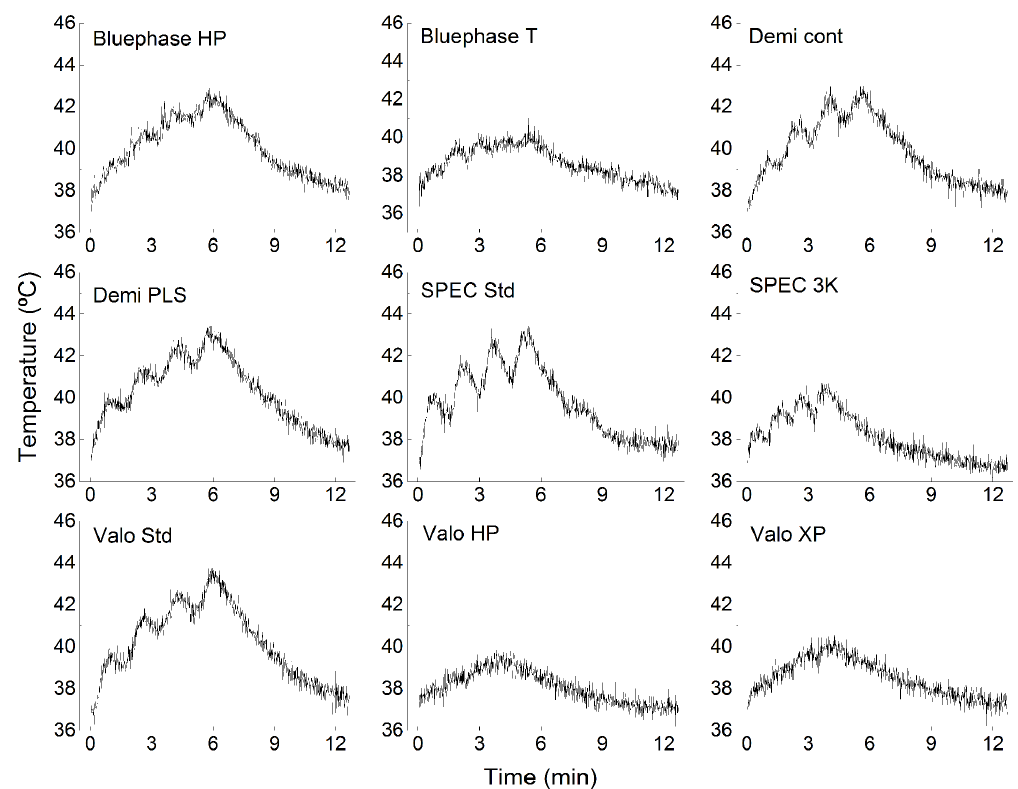
Figure 1. Representative real-time graphic profiles of pulp temperature (PT) increase during the curing protocol for all exposure modes.